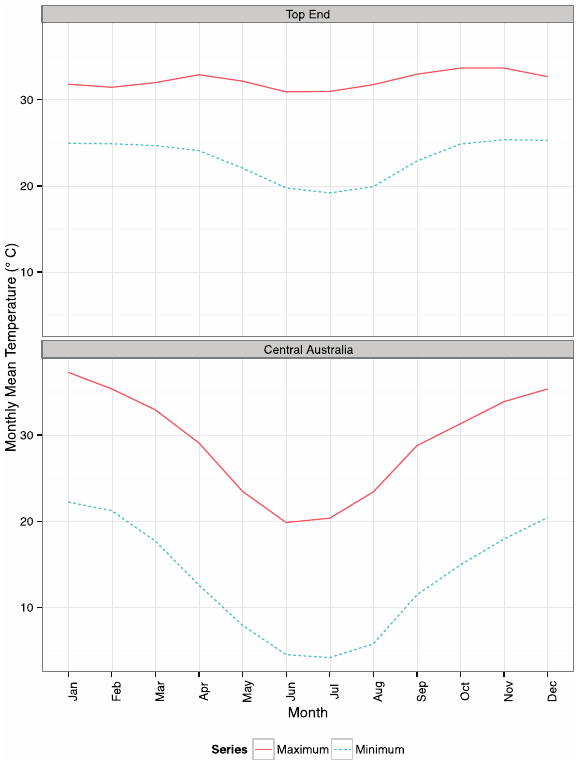
Figure 2. Mean monthly maximum and minimum temperatures for Darwin Airport RCS and Alice Springs Airport RCS, representing the “Top End” and “Central Australia” climate zones